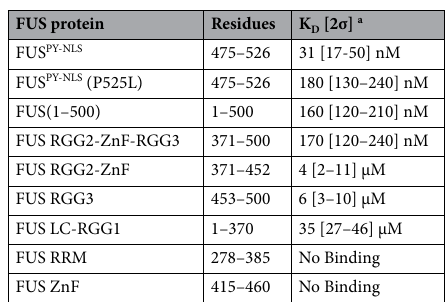
Table 1. ITC Measurements of Kap2 binding to FUS fragments. a The 95% confidence interval range